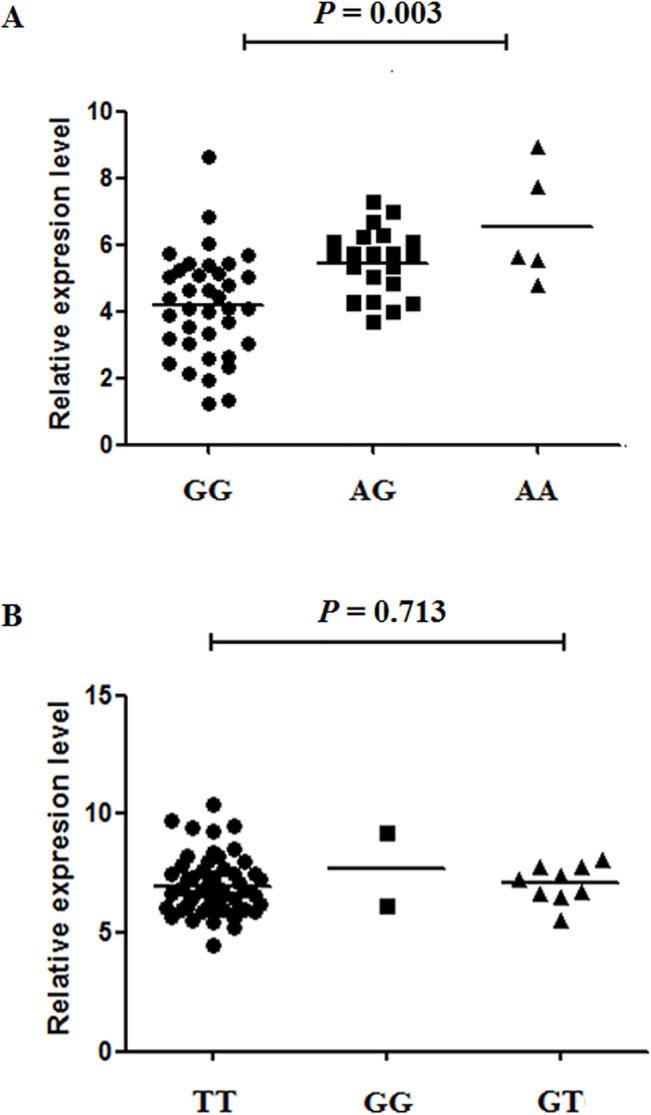
Expression of Cav-1 in cancer adjacent normal renal tissues.(A), Samples with rs1049334 AG or AA genotypes were associated with higher expression levels of Cav-1 mRNA compared with samples with GG genotypes in normal tissues of ccRCC patients (P = 0.003). (B), No significant differences in ROCK1 expression among different ROCK1 rs35996865 genotypes were observed (P = 0.713).